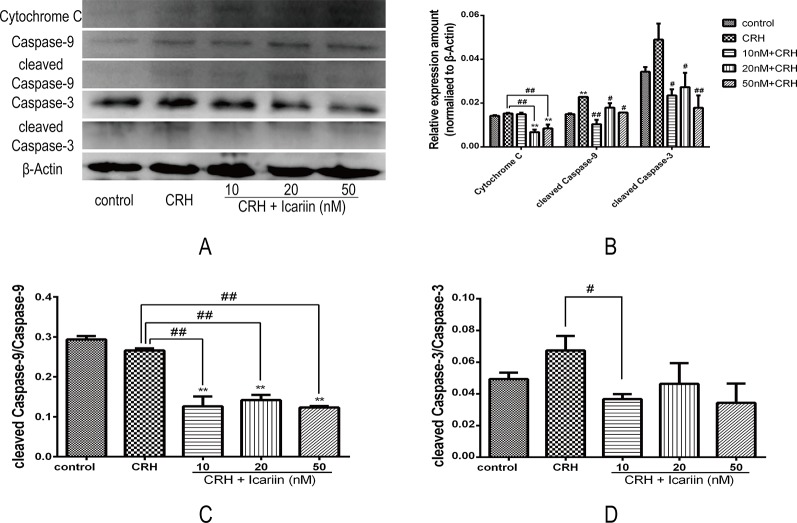
Icariin alleviated apoptosis of hippocampal neurons by reducing expression of apoptosis related proteins in fetal hippocampal neurons. Primary cultured rat hippocampal neurons were pretreated with different concentrations of icariin (10, 20, or 50 nM) for 2 h followed by treatment of CRH for 24 h. The immunoblotting (A) and the histogram of apoptosis related proteins (B) as well as the ratio of cleaved caspase-9 (C) and cleaved caspase-3 (D) showed protein expression in fetal hippocampal neurons among different groups. β-actin was reused from Figure 3. **p < 0.01 vs. control; #p < 0.05 and ##p < 0.01 vs. CRH.